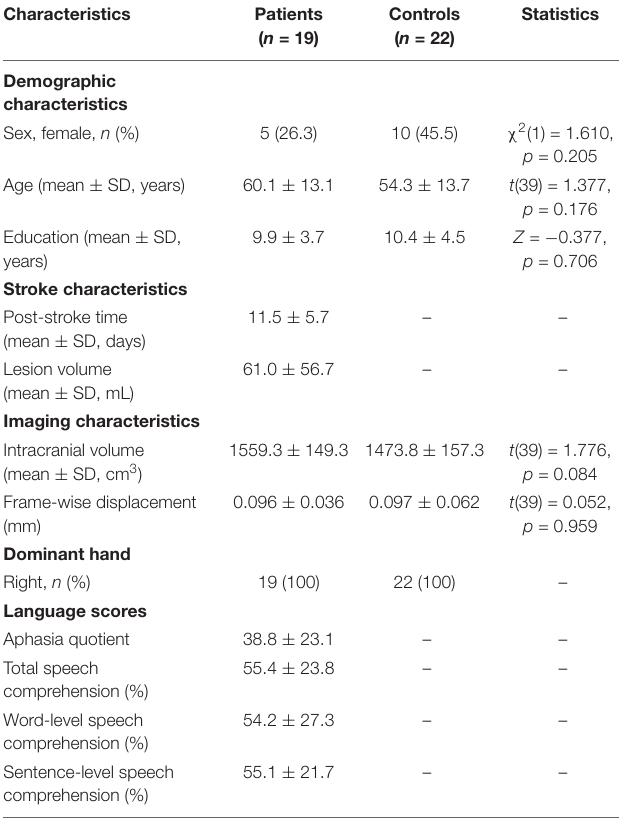
TABLE 1 | Demographic and clinical features of participants in different groups ( n =